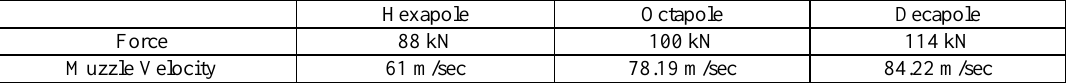
Table 3. Comparison of performance of system for different number of accelerating